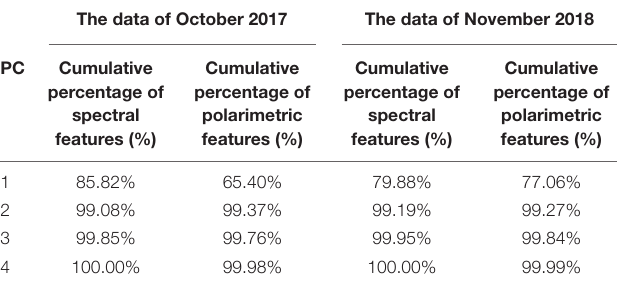
TABLE 3 | Principal component analysis